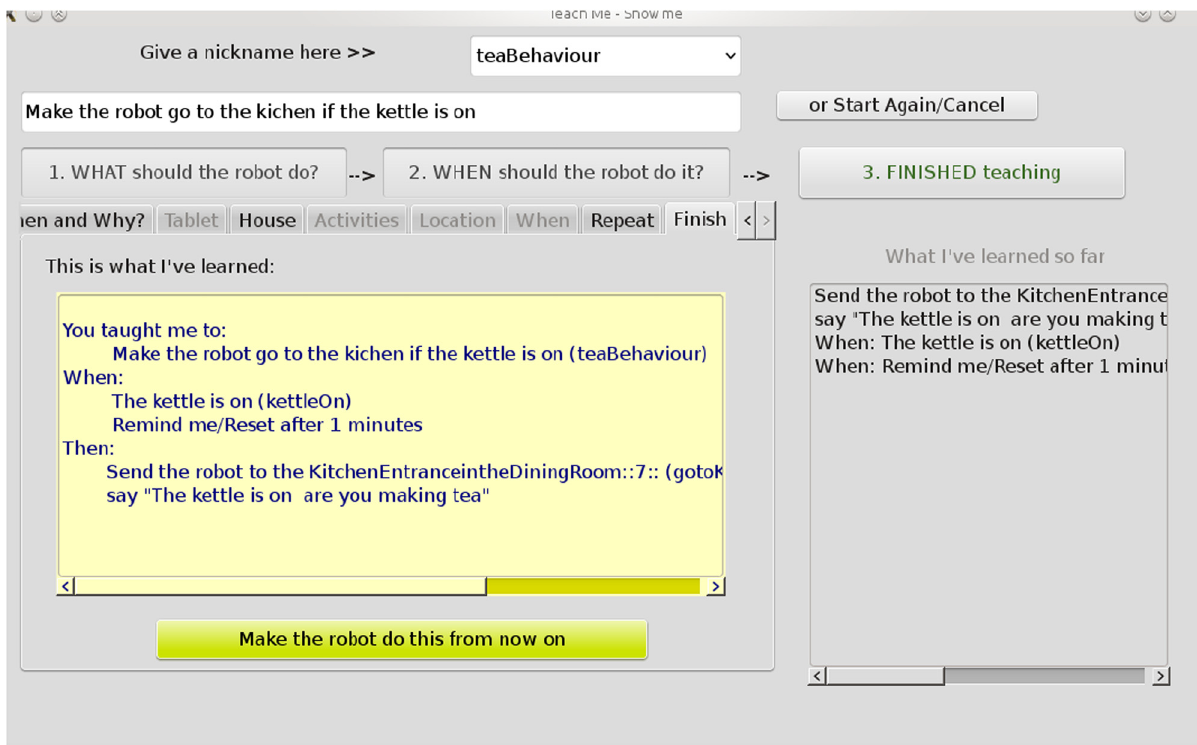
Figure 5: Screenshots of the TEACH M E teaching interface. The user reviews the complete taught